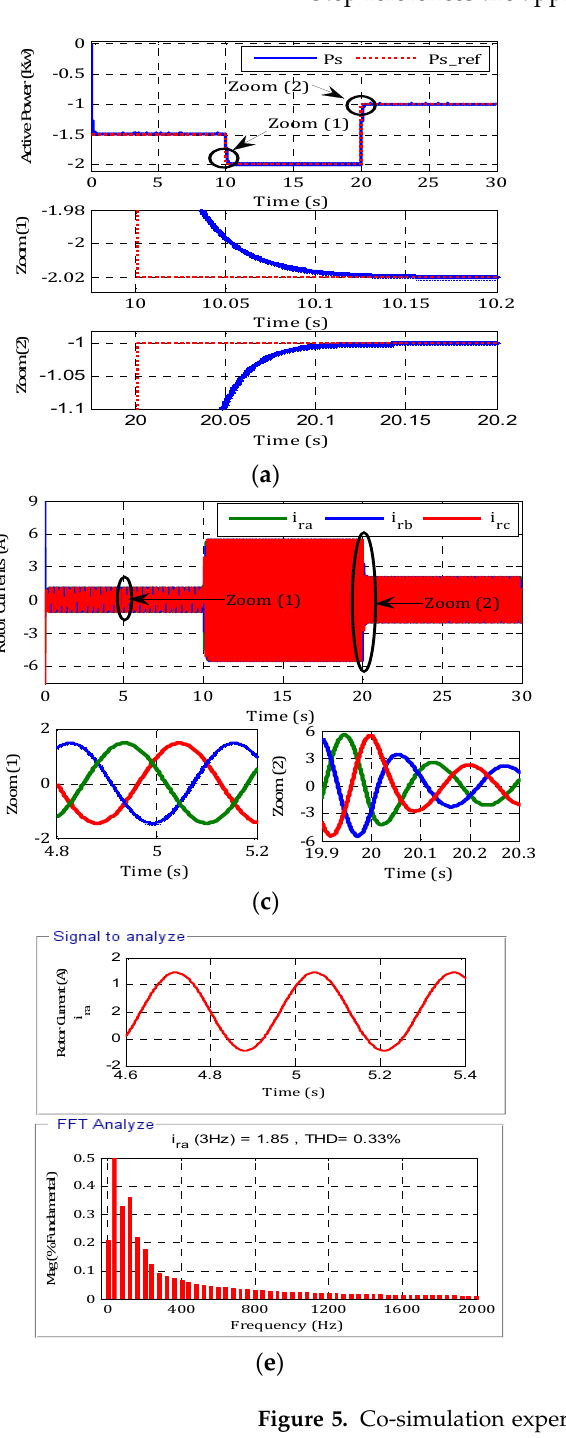
Figure 4. Analyzed THD (%).